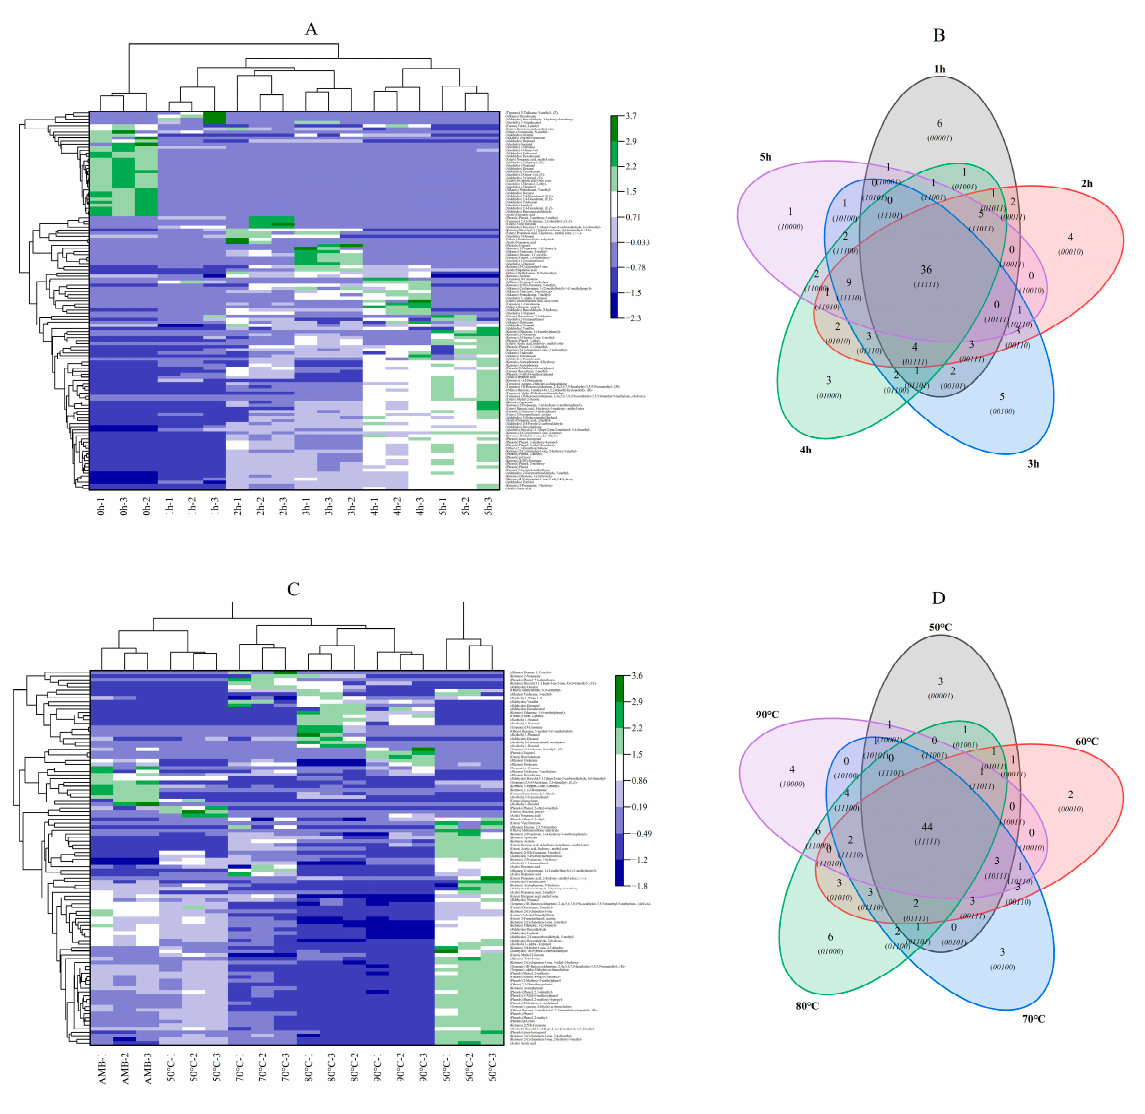
Figure 3. Cluster analysis diagram of VOCs in smoked pork patties at different durations ( A ) and temperatures ( C ). Wayne diagram of VOCs in smoked pork patties at different durations ( B ) and temperatures ( D ). AMB represents ambient